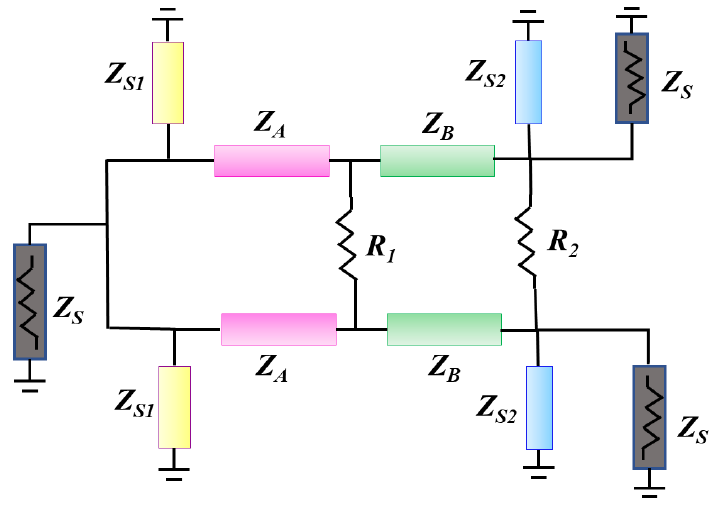
Figure 1. Schematic of the proposed wideband